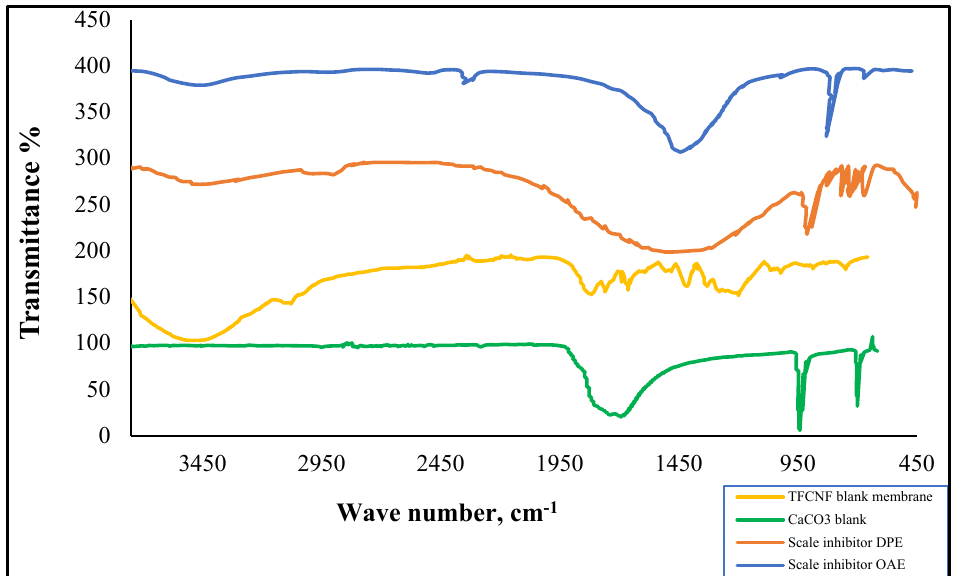
Figure 14. FTIR of TFCNF membrane (a) blank membrane; (b) scaled membrane without inhibitors; (c) with S.I. DPE injection; and (d) with S.I. OAE injection. Calcite peaks at 1400 cm − 1 , 1020 cm − 1 , 1500 cm − 1 , and 1650 cm − 1 attribute to polymorph